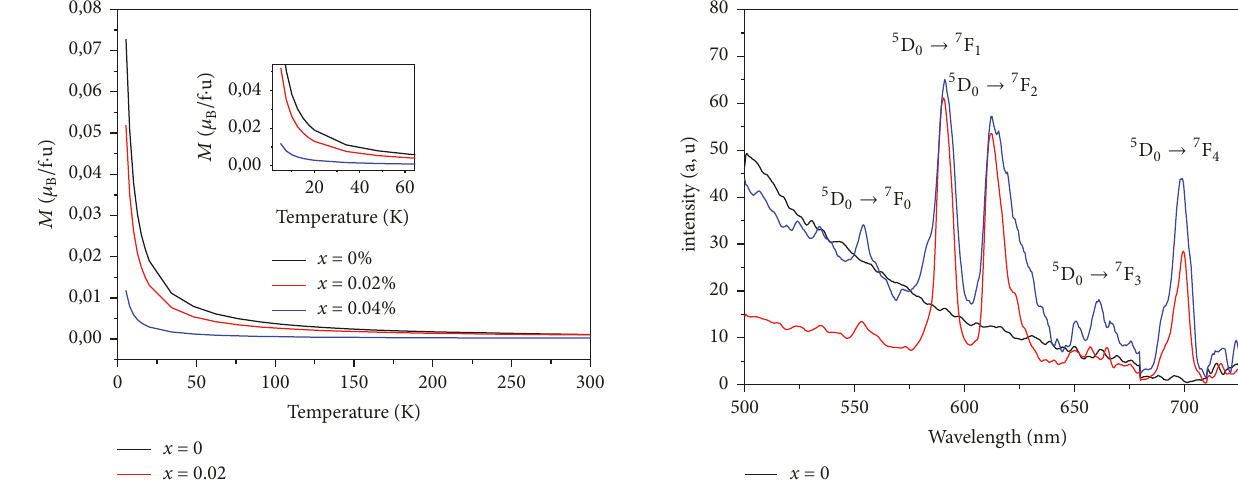
Figure 10: Magnetic measurements of LiGd (1 0.02 and 0.04).